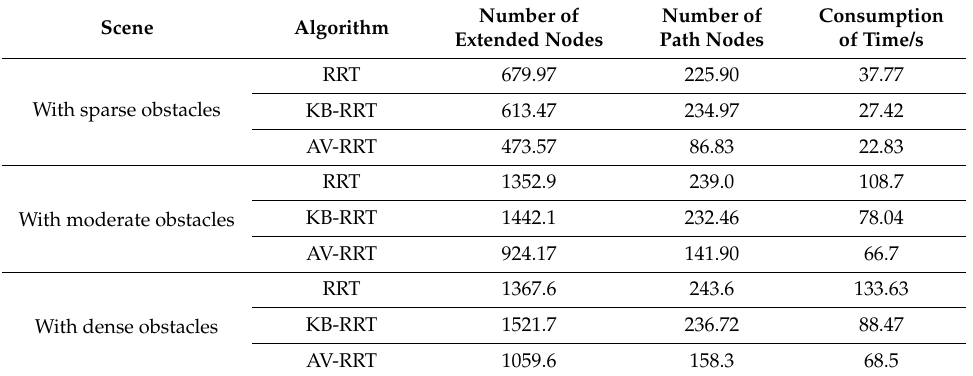
Table 6. Comparison of performance indexes of three algorithms.